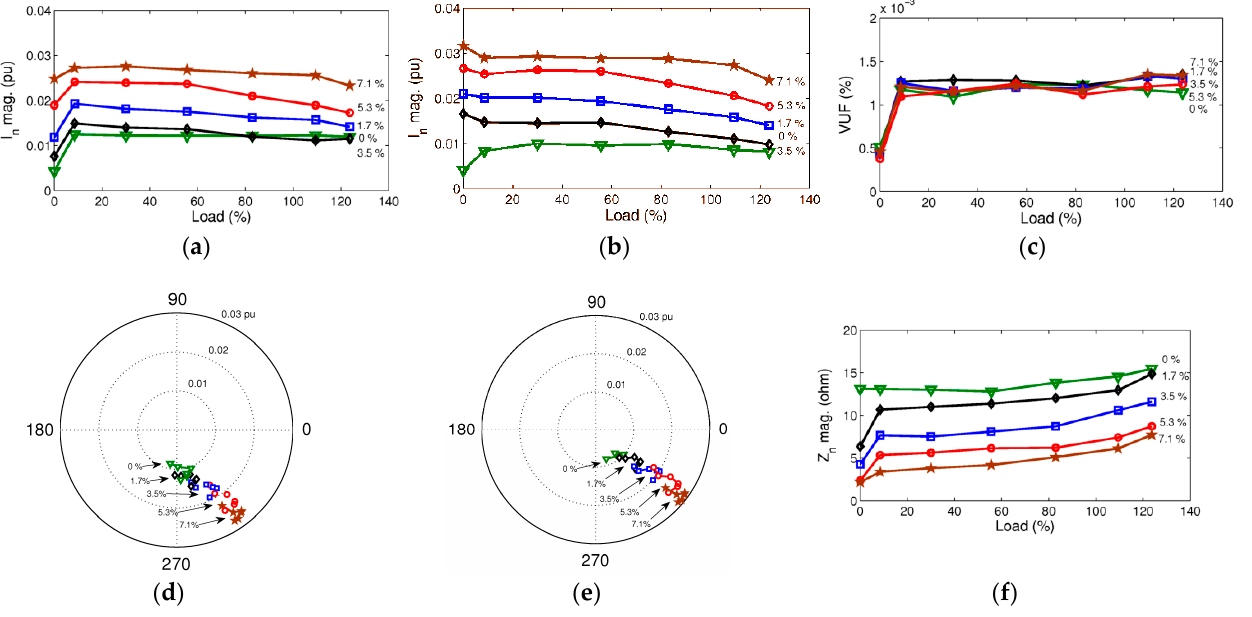
Figure 15. The test results at various shorted turn fault levels of 0% (triangle), 1.7% (diamond), 3.5% (square), 5.3% (circle) and 7.1% (star), before inherent asymmetry elimination of the magnitude of I n ( a ), phasor diagram of I n ( d ), after inherent asymmetry elimination of the magnitude of I n ( b ), phasor diagram of I n ( e ), and the corresponding voltage unbalance factors and ( c ) the negative sequence impedances ( f ).